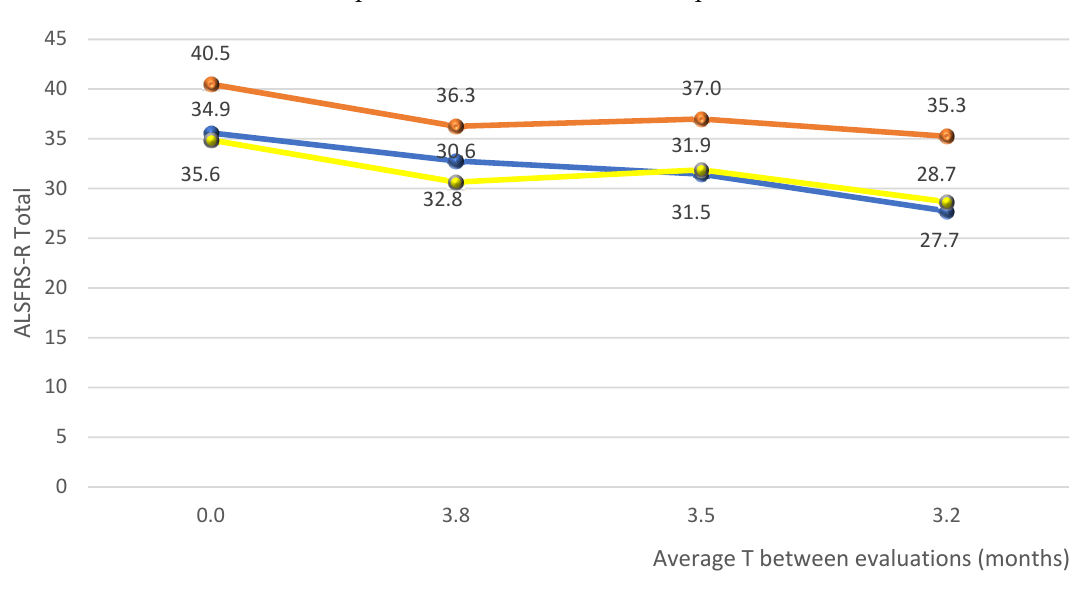
Figure 2. Averages of the total score of the functionality scale for the diagnostic groups and the whole cohort studied. Abbreviations: ALSFRS-R (Amyotrophic Lateral Sclerosis Functional Rating Scale–Revised); SG (Spinal group); BG (Bulbar group).